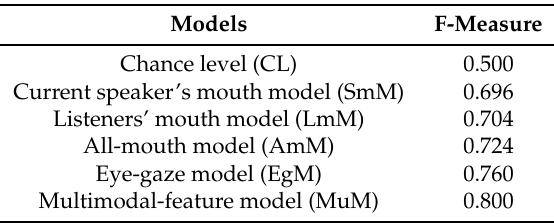
Table 1. Evaluation results of prediction models of turn-keeping and turn-changing. Values shown are mean of F-measures by ten-fold